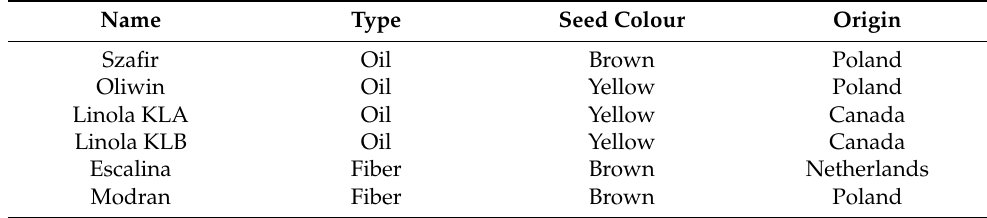
Table 1. The origin of flax genotypes used as genetic material and fatty acid composition in half-seeds. Name Type Seed